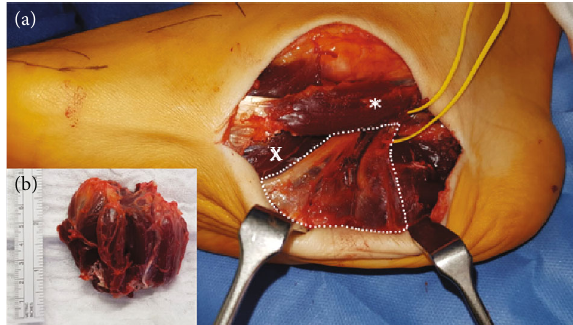
Figure 4: Intraoperative photograph (a) displaying the medial approach: reduction-plasty of abductor hallucis brevis muscle ( ∗ ); (b) shows the resected muscular portion), fl exor digitorum brevis muscle in depth (x), and the delta-shaped neurovascular bundle (framed with white dots).